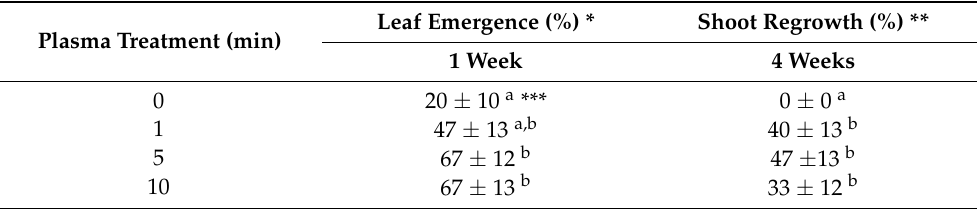
Table 2. The effect of plasma treatment on germination of chrysanthemum synseeds grown in vitro on vermiculite + liquid medium. Leaf Emergence (%) * Shoot Regrowth (%) ** Plasma Treatment (min) 1 Week 4 Weeks 0 20 ± 10 a *** 0 ± 0 a 47 ± 13 a,b 67 ± 13 b 33 ± 12